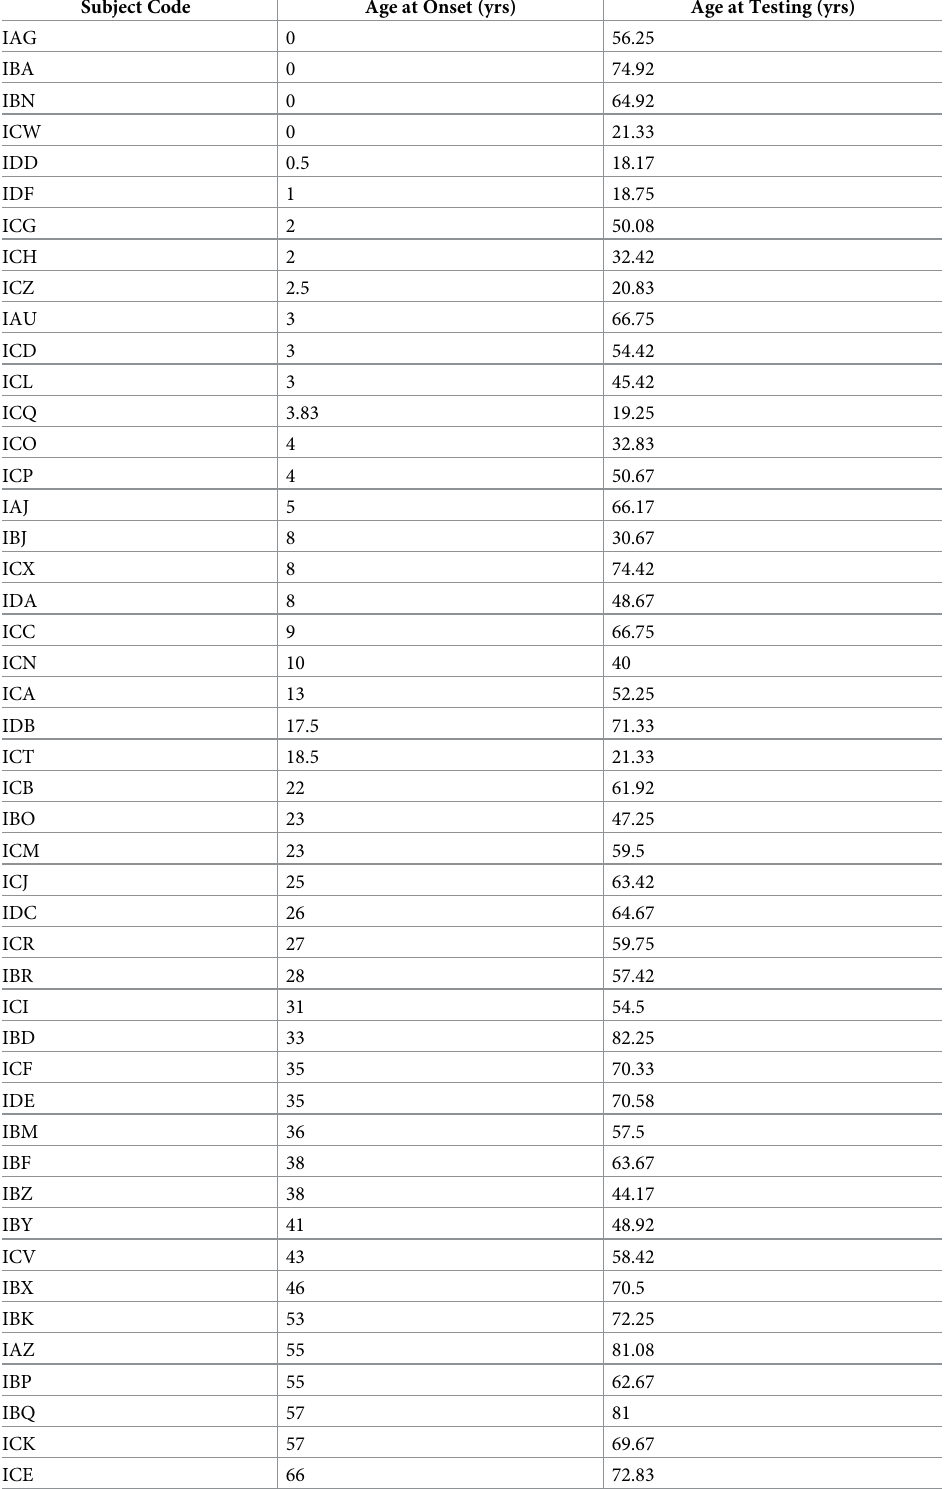
Table 1. Demographic information for listeners with